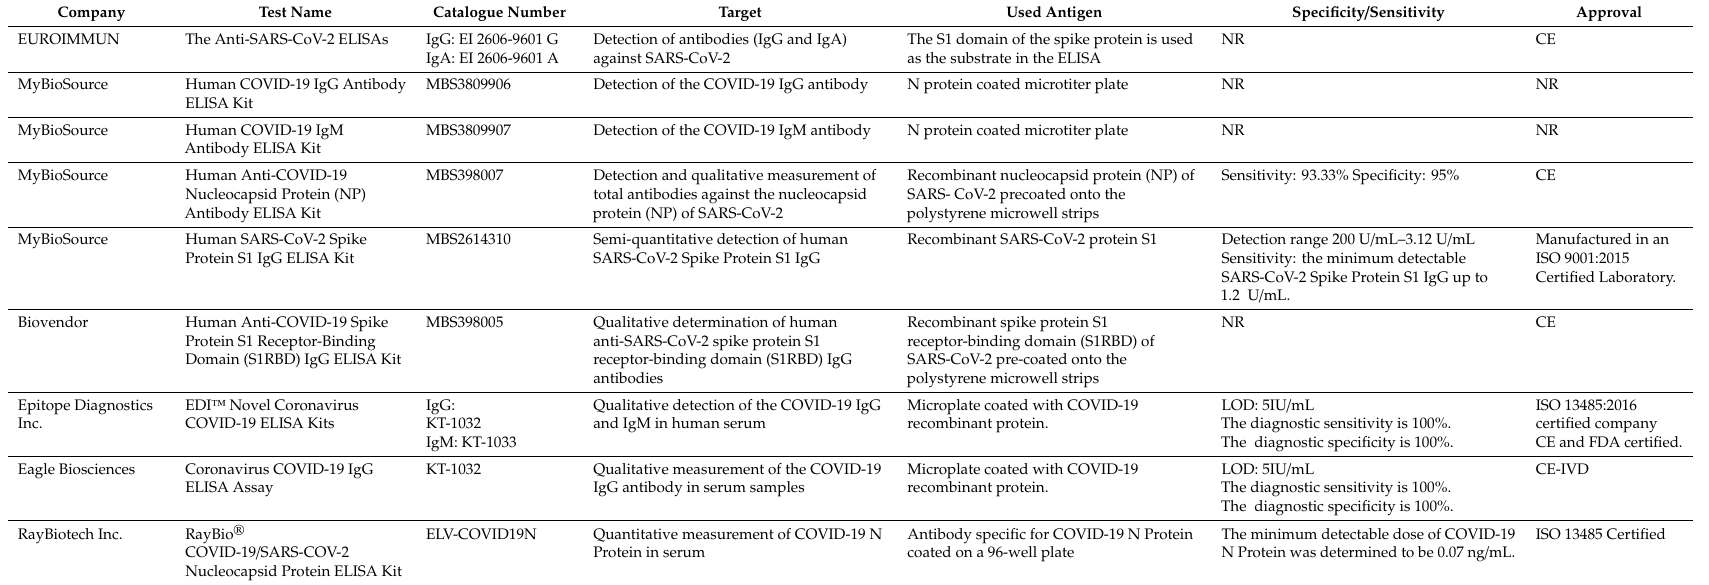
Table A2. Specifications of the available serological commercial kits laboratory diagnosis of